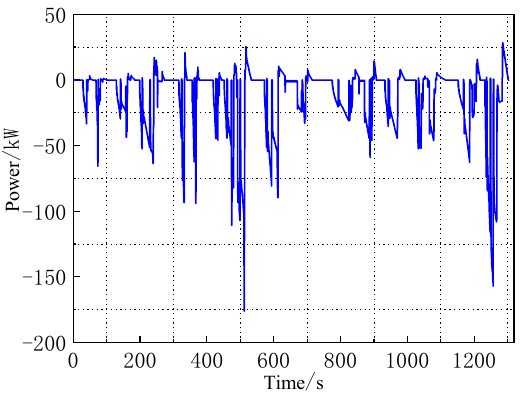
Figure 13. Current when battery is powered alone.